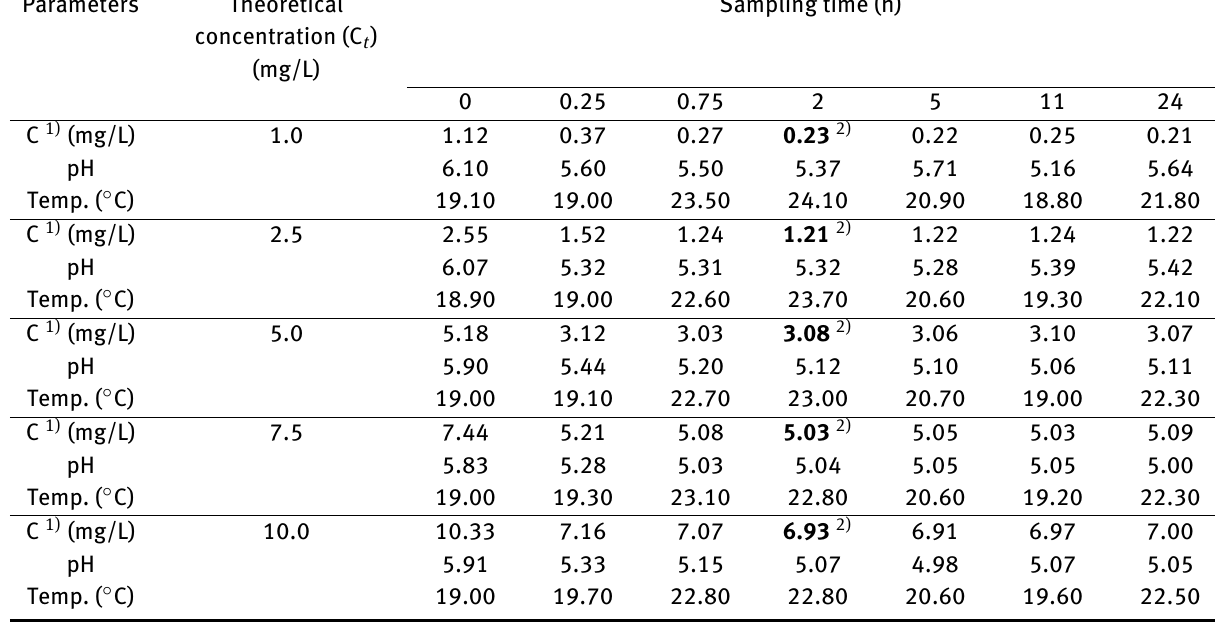
Table 3: Results for experiments with